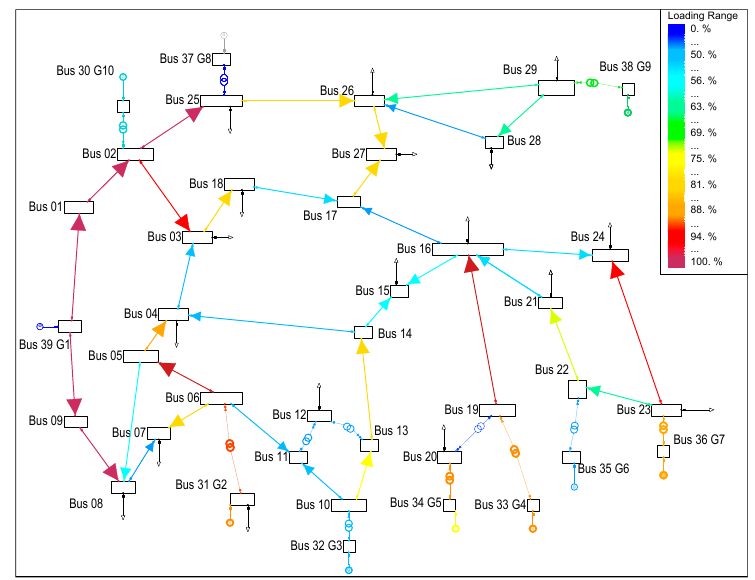
Figure 9. Maximum loadability of elements after outage of G8.